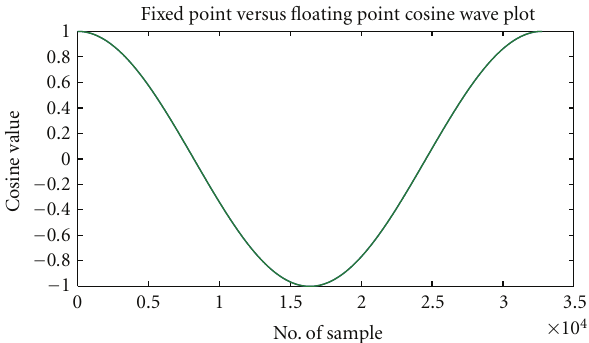
Figure 12: Plot of software-generated versus hardware-generated (using proposed ROM-based DDFS) cosine wave.